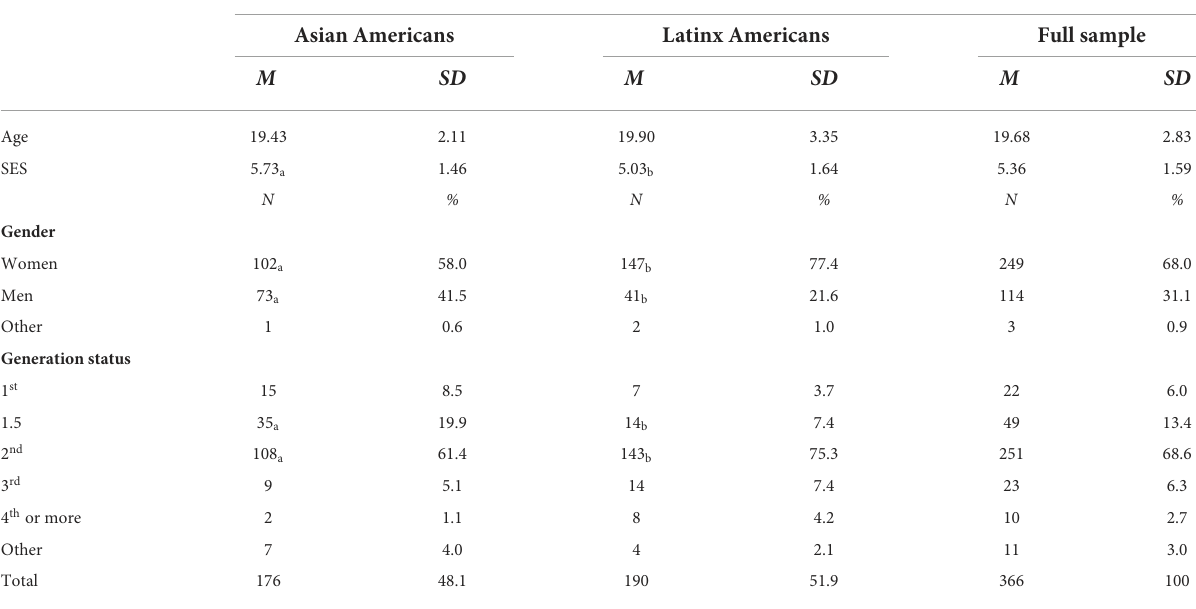
TABLE 1 Demographic characteristics and descriptives of study variables compared across Asian and Latinx Americans for study 1 (April 2020–April 2021).